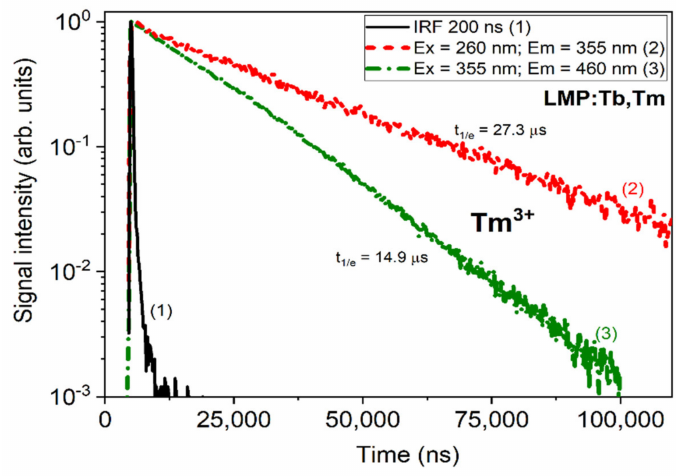
Figure 8. Thme luinescence decay kinetics of Tm 3 + ions at 355 nm and 460 nm under excitation in the respective excitation bands of Tm 3 + ions. The instrumental response function (IRF) is also